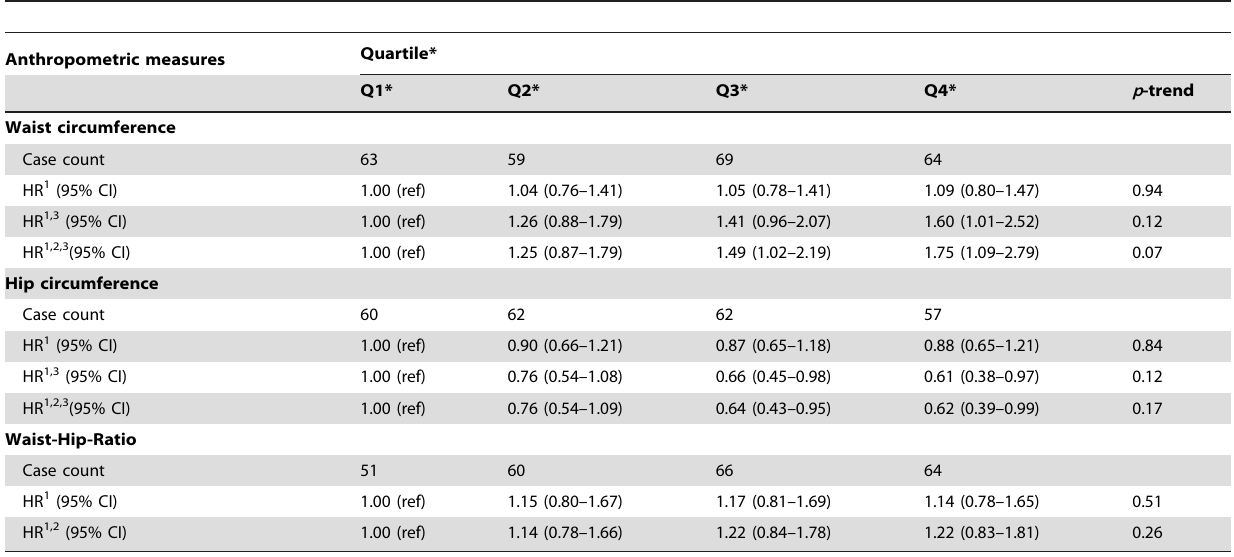
Table 3. Hazard ratios (HR) and 95% confidence intervals (CI) for waist/hip ratio, waist circumference, and hip circumference in relation to lung cancer risk among never smokers, NIH-AARP Diet and Health Study